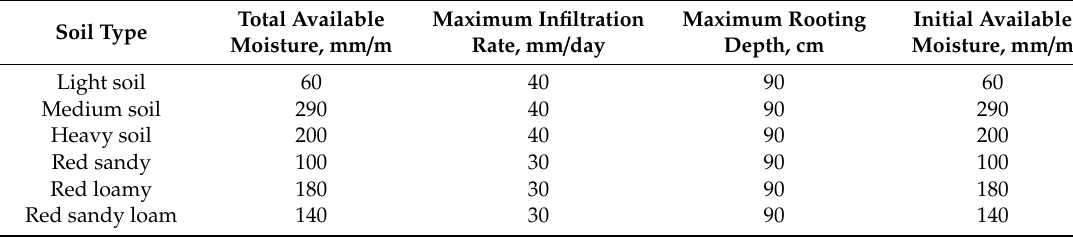
Table A14. Soils information for water footprint calculation